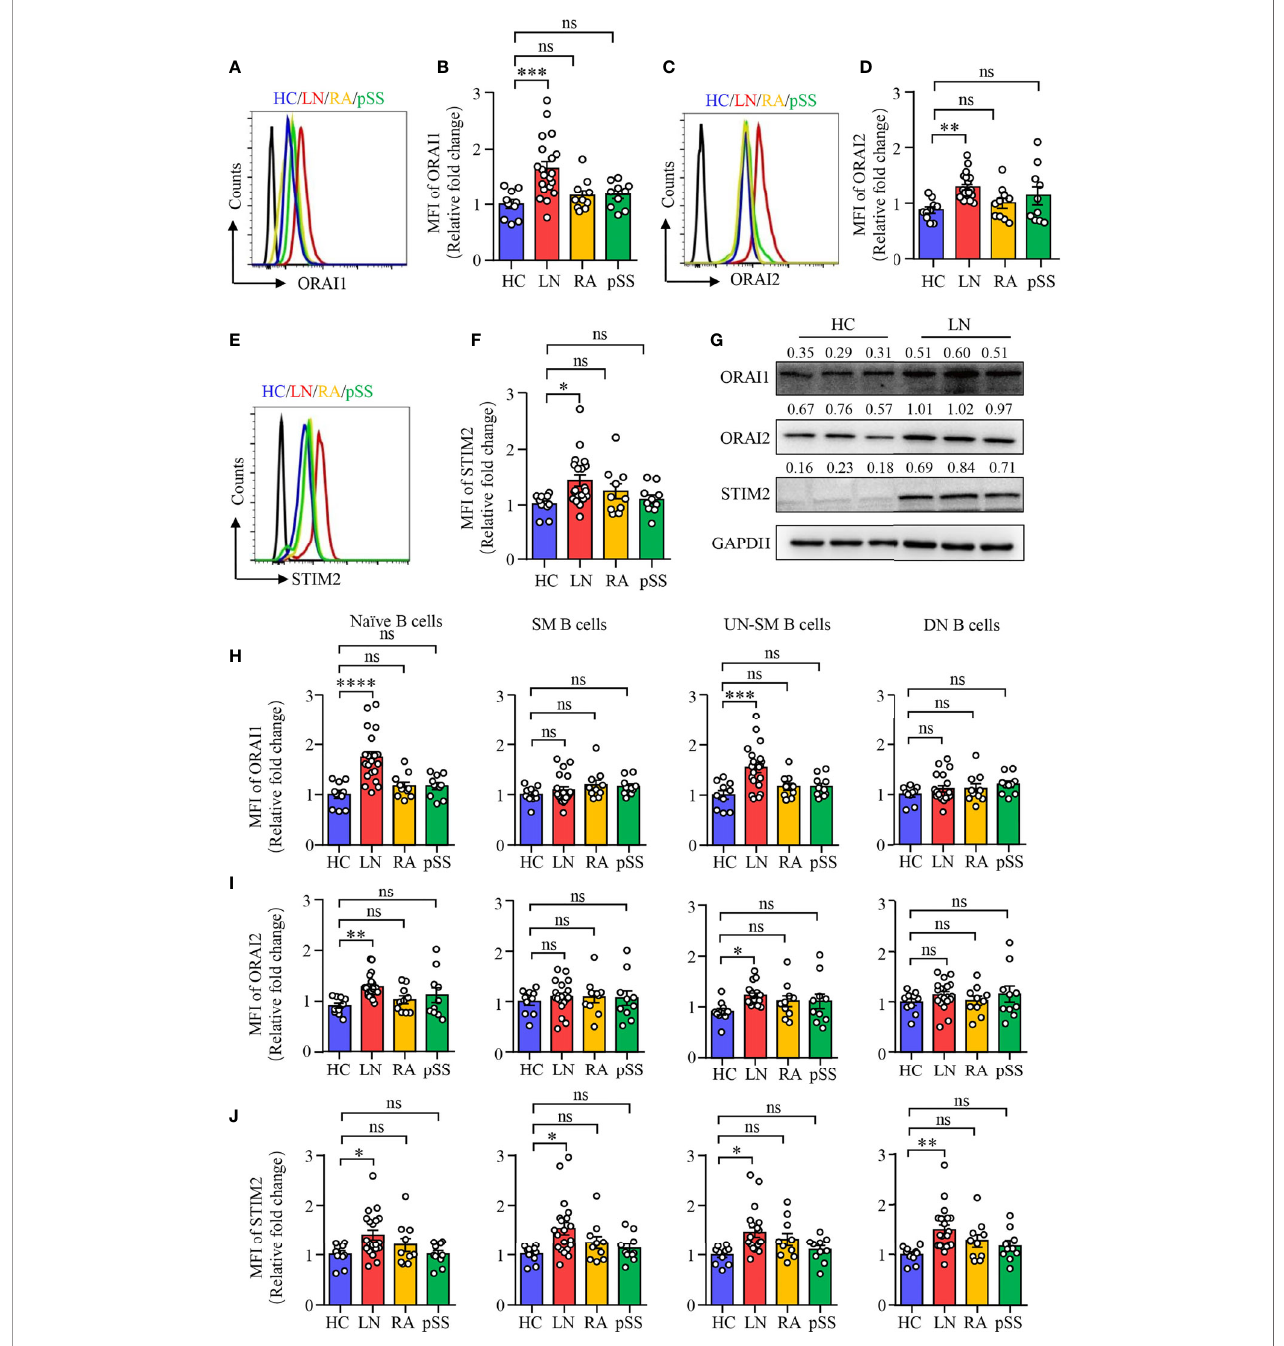
FIGURE 2 | Increased CRAC channel in B cells from patients with LN. PBMCs were isolated from patients with lupus nephritis (LN), rheumatoid arthritis (RA), primary Sjogren ’ s syndrome (pSS), or healthy controls (HC). Orai1, Orai2, and STIM2 expression in B cells was measured by fl ow cytometry or Western blot. (A – F) ORAI1, ORAI2, and STIM2 expression in B cells from LN, RA, pSS, or HC was measured by fl ow cytometry. Representative histograms were gated on CD19 + B cells. Mean fl uorescence intensity (MFI) of ORAI1, ORAI2, and STIM2 from LN (n = 20), RA (n = 10), pSS (n = 10), or HC (n = 10) were summarized. (G) CD19 + B cells were isolated from LN or HC. ORAI1, ORAI2, and STIM2 expression in B cells were measured by Western blot. GAPDH was used as internal control, and relative expression values are indicated above each lane. Representative bands are shown. (H – J) Mean fl uorescence intensity (MFI) of Orai1, Orai2, and STIM2 in naive B cells (CD19 + IgD + CD27 − ), switched memory B cells (CD19 + IgD − CD27 + , SM), unswitched memory B cells (CD19 + IgD + CD27 + , UNSM), and double-negative B cells (CD19 + IgD − CD27 − , DN) were analyzed by fl ow cytometry and are summarized in dot plot with bar plot. All data are mean ± SEM. *p < 0.05, **p < 0.01, ***p < 0.001 and ****p < 0.0001 by one-way ANOVA. ns, not signi fi